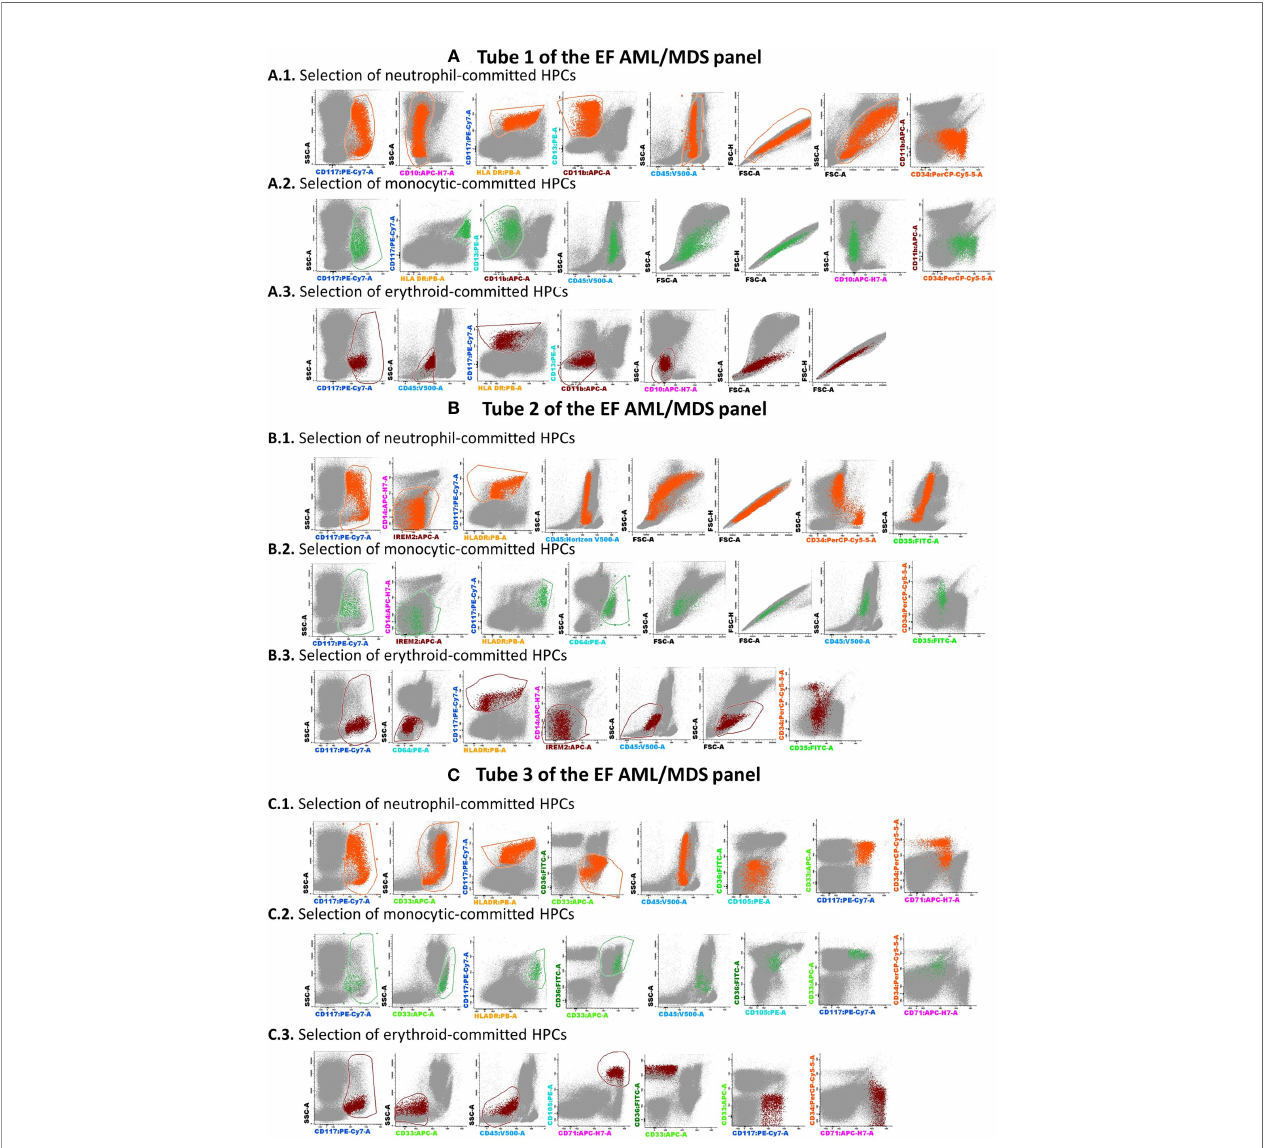
FIGURE 2 | The analysis strategy for the identi fi cation of normal myeloid-committed HPCs using Tubes 1 – 3 of the EF AML/MDS panel. The discrimination of normal my-HPCs was performed by In fi nicyt 2.0 software, based primarily on the backbone markers CD117, human leukocyte antigen-DR (HLA-DR), and CD45. Several exclusion gates were used to avoid the inclusion of undesirable events that may fall into the blast gate, such as CD11b + hypogranular neutrophils and basophils (Tube 1), CD14 +low granulocytes and CD14 + CD300e (IREM-2) + monocytes (Tube 2), and CD10 + hematogones (Tube 1). Bivariate dot plot histograms illustrating the HPCs committed toward a neutrophil lineage (CD45 +low/int CD117 + CD34 +/ − HLA-DR +int CD13 + CD14 − IREM2 − CD33 + CD36 − ; orange dots), a monocyte lineage (CD45 +low/int CD117 + CD34 +/ − HLA- DR +high CD64 + CD14 − CD300e/IREM-2 − CD13 + CD33 + ; green dots), or an erythroid lineage (CD45 +low/ − CD117 + CD34 +/ − HLA-DR +low/int CD36 + CD105 + CD33 − CD35 +low ; dark-red dots). The other bone marrow cells are displayed in gray. (A) tube 1 EF AML/MDS panel; (B) tube 2 EF AML/MDS panel, (C) tube 3 EF AML/MDS